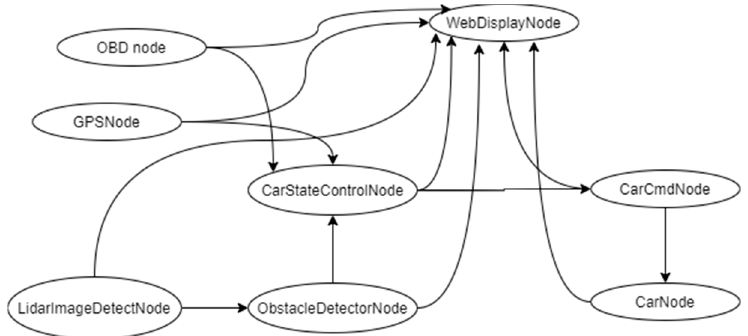
Figure 3. Nodes in ROS solution.